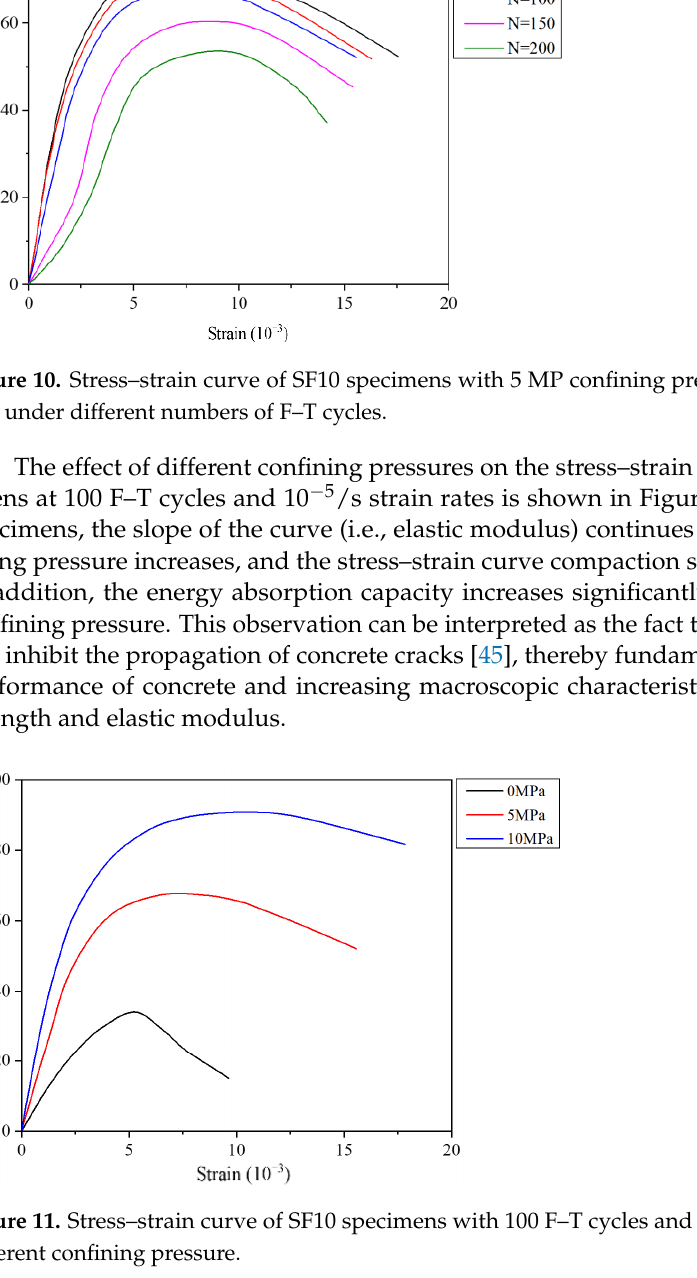
11 of 23 Figure 9. Peak strain of concrete specimens with 100 F – T cycles under different confining pressures. ( a ) SF0. ( b ) SF10. ( c ) SF20. Figure 9 displays the impact of confining pressure on the axial peak strain of all mixes. The axial peak strain of all concrete showed a continuous increasing trend with increasing confining pressure. When the confining pressure is increased from 0 to 10 MPa for SF0, the axial peak strain (Figure 9a) rises by 98.0% at a 10 −5 /s strain rate. Furthermore, for SF10 at a 10 −5 /s strain rate, the axial peak strain (Figure 9b) increased from 0.0057 to 0.0113 with the strain rate was raised from 0 MPa to 10 MPa. For concrete with 2% steel fibers (SF20), the results are consistent with those for SF0 and SF10 shown in Figure 9c. This result is in line with research by Wang et al. [44], who found that the peak strain of the specimen rises with increasing confining pressure. Furthermore, Figure 9 demonstrates that adding steel fiber in the test will increase the axial peak strain of concrete. When the confining pressure is 0 MPa, for instance, the peak strain of SF10 and SF20 increases by 14.9% and 19.1%, respectively, over that of SF0 at a 10 −5 /s strain rate. 3.3. Axial Stress – Strain Behavior The influence of F – T cycle number on the stress – strain behavior of SF10 specimens at a 5MP confining pressure and a 10 −5 /s strain rate is shown in Figure 10. The peak value